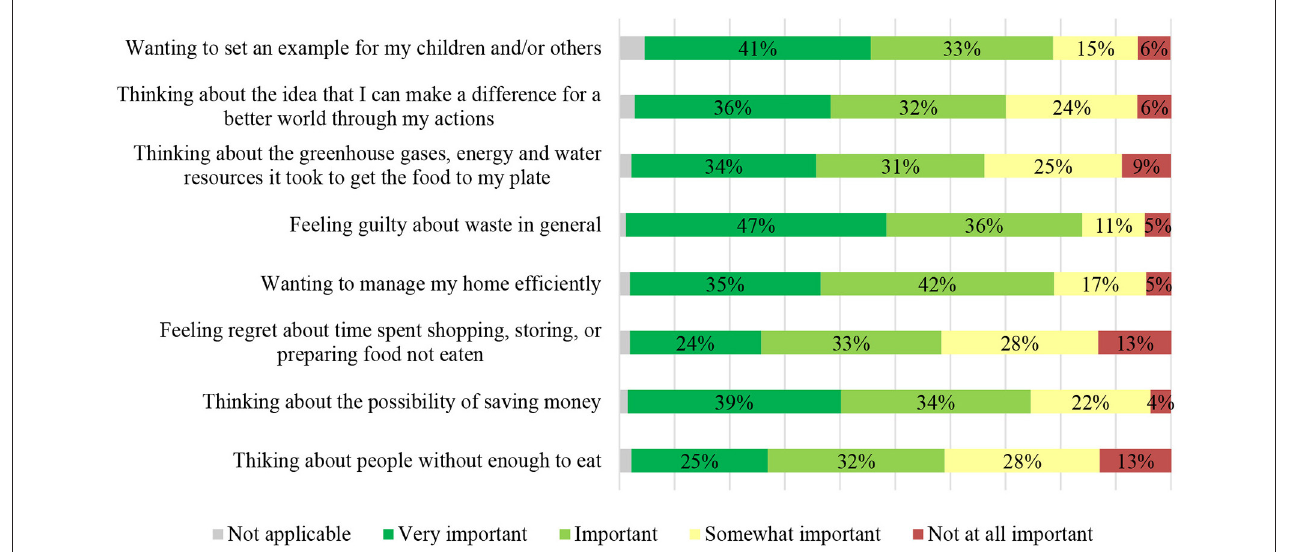
FIGURE 5 | Motivating factors for reducing food waste. Participants were asked to report how important the following factors are in motivating them to reduce food waste (values < 5% not labeled in